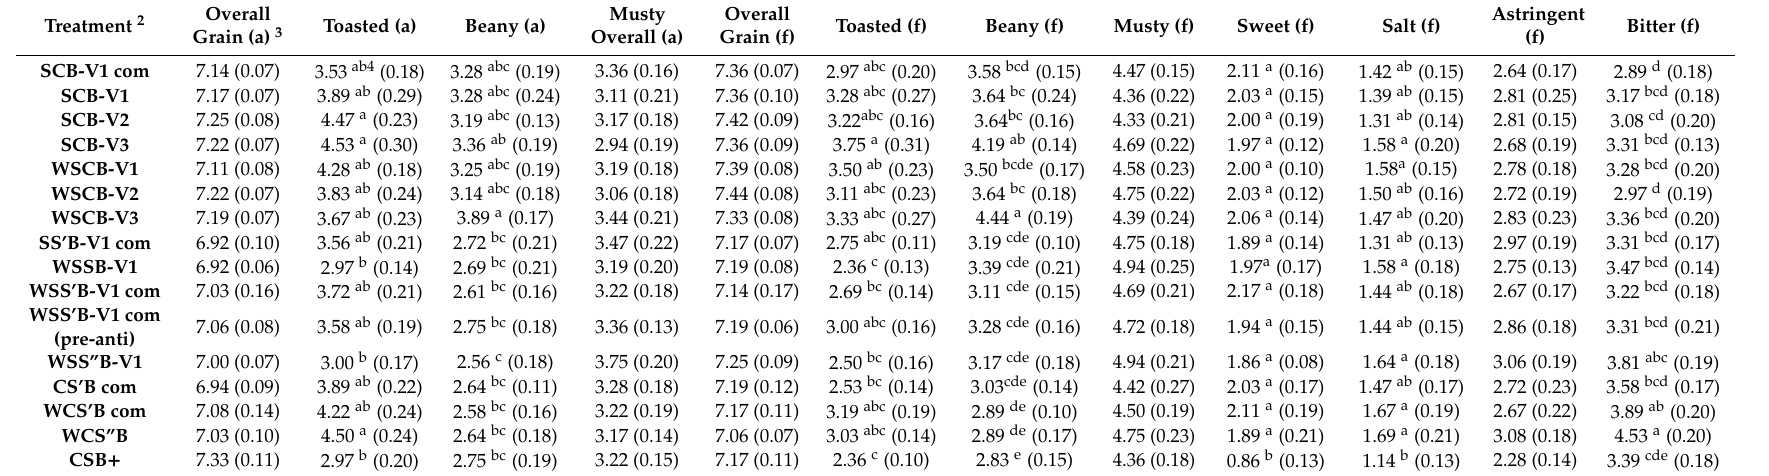
Table 4. Mean scores 1 (standard error) of sensory attributes for porridges prepared from FBFs. Treatment